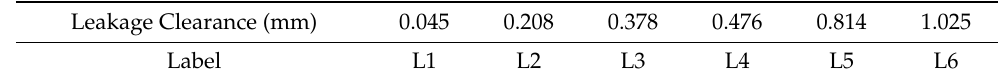
Table 5. Leakage clearance of hydraulic